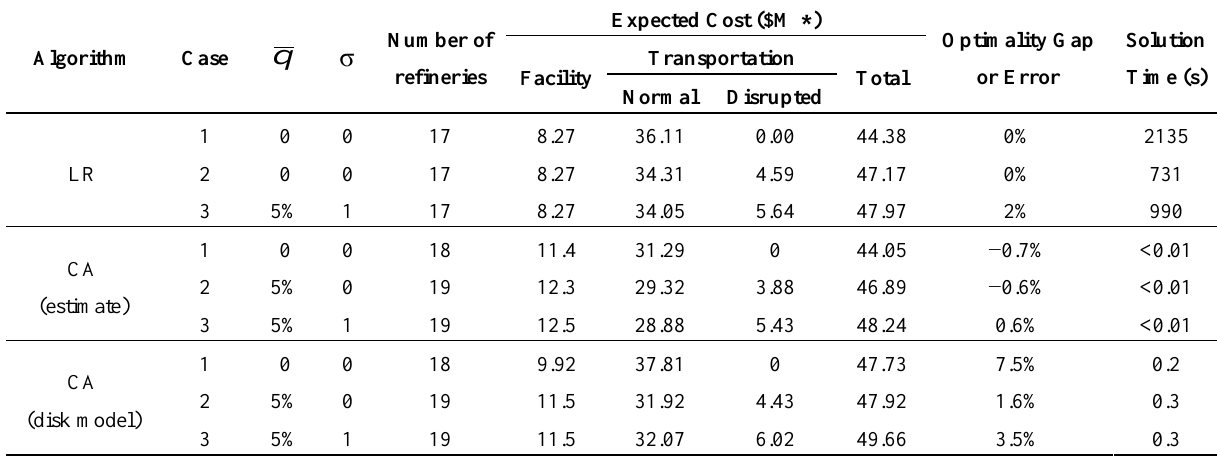
Table 1. Summary of different model solutions for different cases.